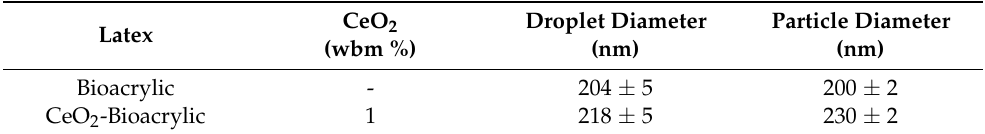
Table 2. Characterization of synthesized latexes. Both latexes have a pH value of 7.